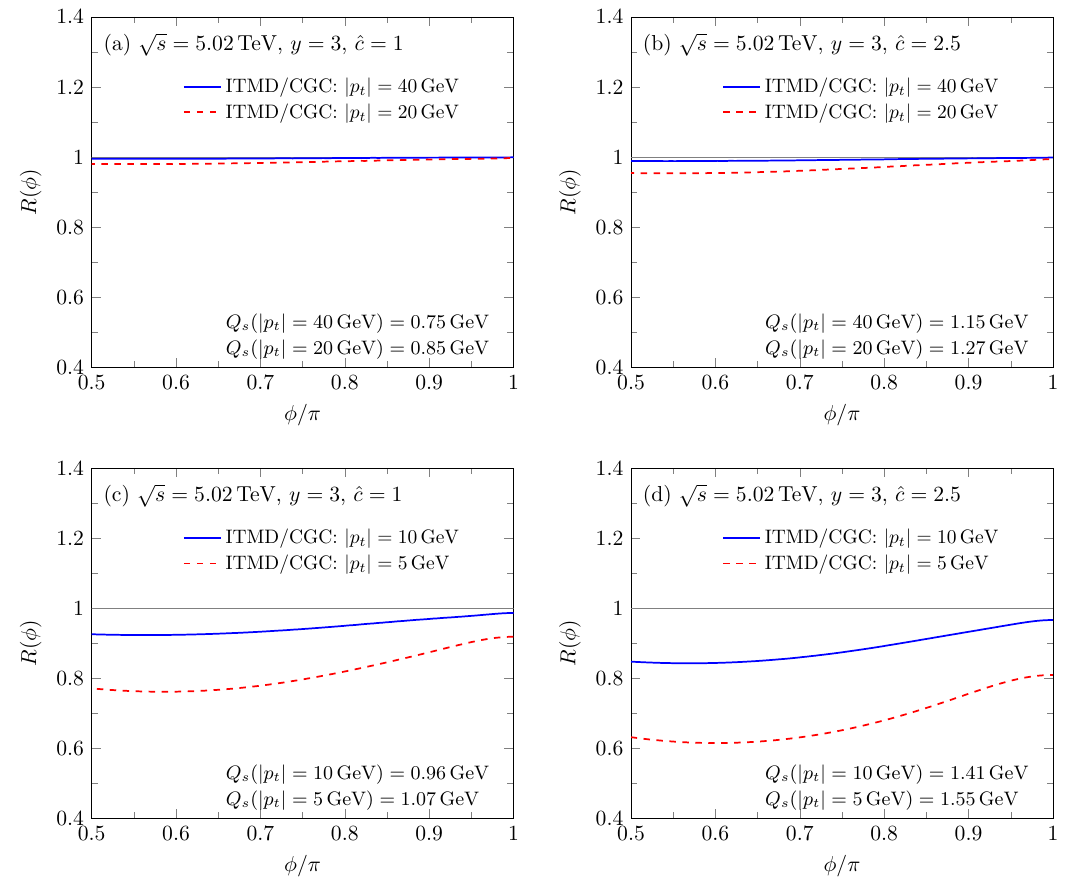
Figure 8 . The ITMD/CGC ratio R in p + p collisions (left; ˆ c = 1 ) and in p + A collisions (right; √ ˆ c = 2 . 5 ) at y = 3 at s = 5 . 02 TeV. (a): Results for | p t | = 40 (blue solid) and 20 GeV (red dashed) in p + p . (b): The same as in (a) but in p + A . (c): Results for | p t | = 10 (blue solid) and 5 GeV (red dashed) in p + p . (d): The same as in (c) but in p + A . The Q s value determined by the gluon TMDs is shown in each